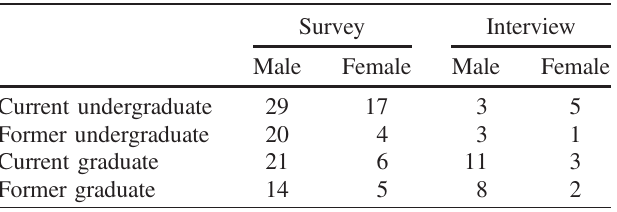
TABLE II. Demographics of survey responses by student gender and classification. A total of 117 complete survey responses were received and 35 interviews were completed. Three survey responses were from undergraduate students who were nonbinary or preferred not to identify their gender. A small number of students completed both their undergraduate and graduate degrees at the same